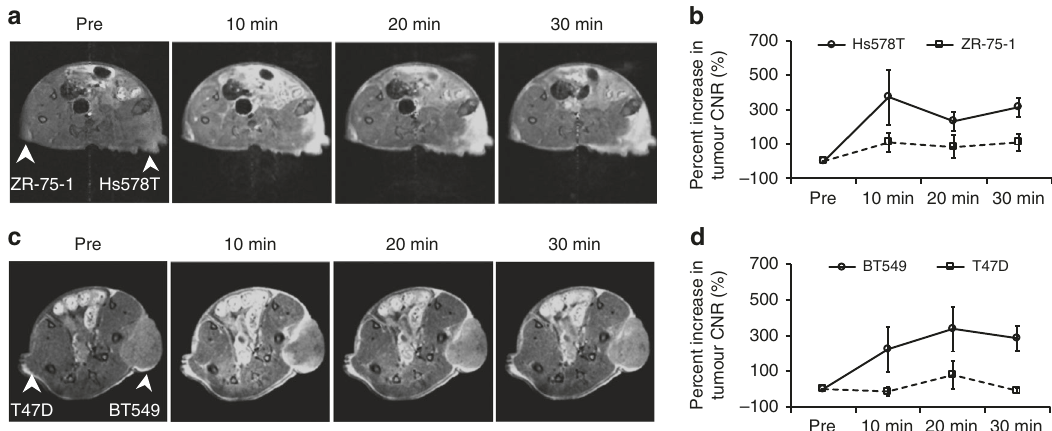
Fig. 5 Molecular MRI with ZD2-Gd 3 N@C80 of other breast tumours in mice. Representative axial MR images (7 Tesla) and tumour CNR analysis of mice bearing Hs578T and ZR-75-1 ( a , b ), BT549 and T47D ( c , d ) xenografts in fl anks. Images were acquired at pre-injection and 30 min post-injection of 20 µ mol Gd/kg ZD2-Gd ± s.e.m. n = 3, two-tailed t -test; * P < 0.05). Tumour locations are indicated with white 3 N@C80 (data are presented as mean − 1 Gd 3 N@C80 (Fig. 4a, b). Co-injection of 1.67 µ mol kg of ZD2-Gd 3 N@C80 with 25 µ mol kg − 1 of ZD2 peptide signi fi cantly